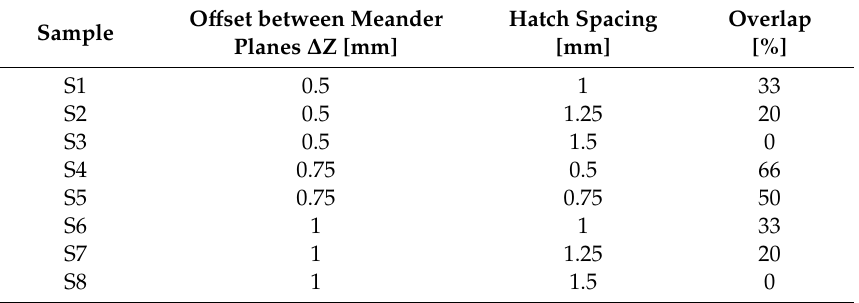
Table 2. Scanning strategy